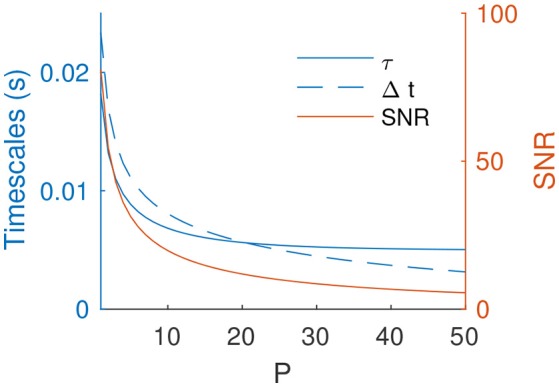
Optimal τ and Δt (for f = 3.2 Hz, T = 3.2 ms) and resulting SNR as a function of P.